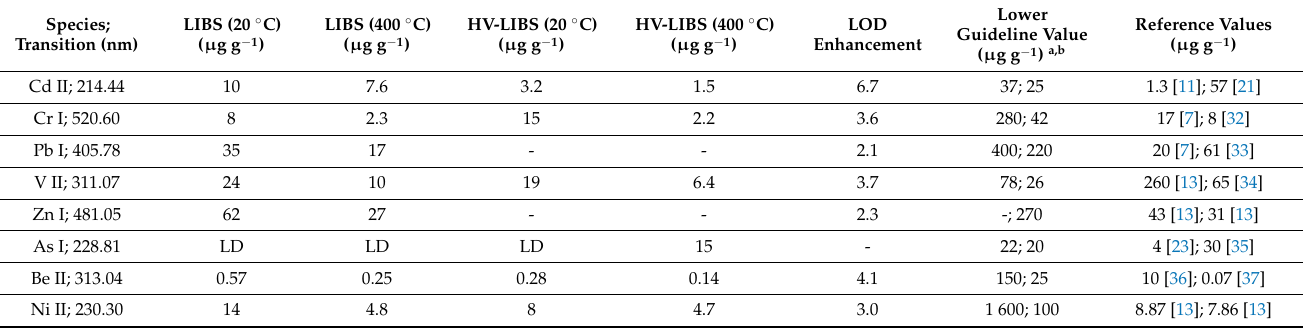
Table 2. Limit of detection (LOD) of LIBS compared to the values obtained by intensification techniques. Species; Transition